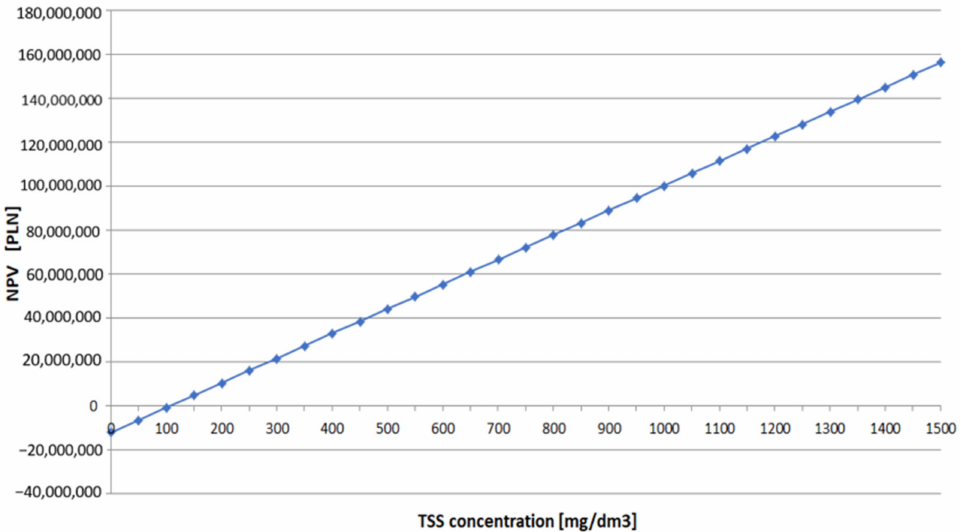
Figure 2. The sensitivity analysis of NPV in relation to the level of a discount rate.